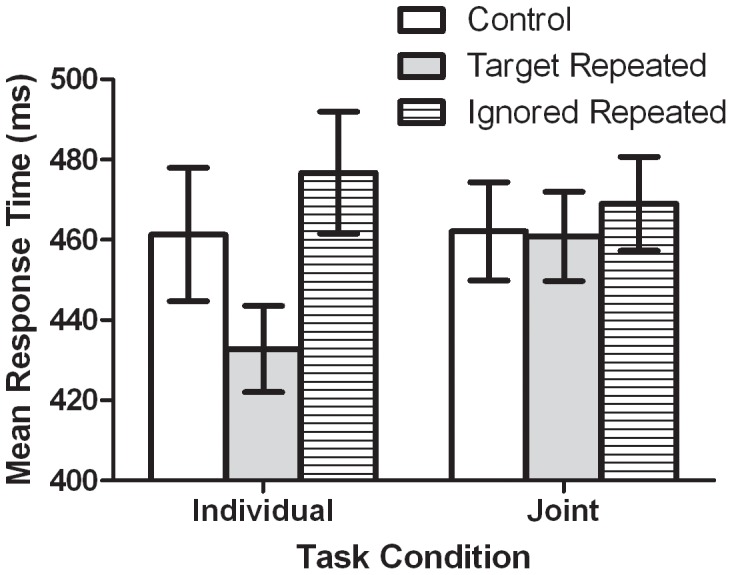
Mean response times (ms) as a function of Person and Target.Open white bars represent values for control trials. Light grey bars represent values for target repetition trials. Bars with horizontal stripes represent values for ignored repetition trials. Standard error of the mean bars are shown.